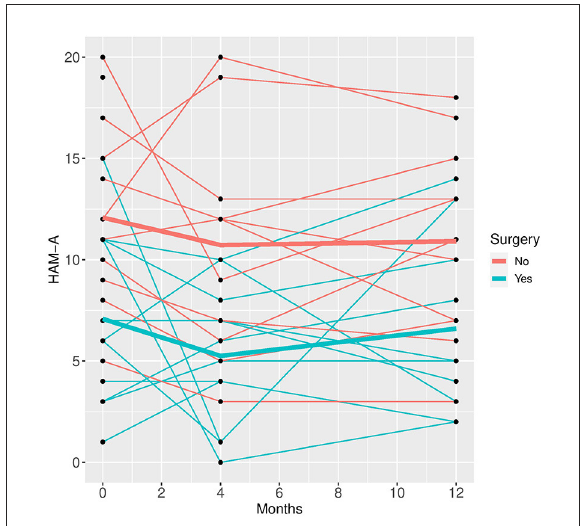
FIGURE5 GAF time course for individual patient data (thin lines) and averaged values (bold